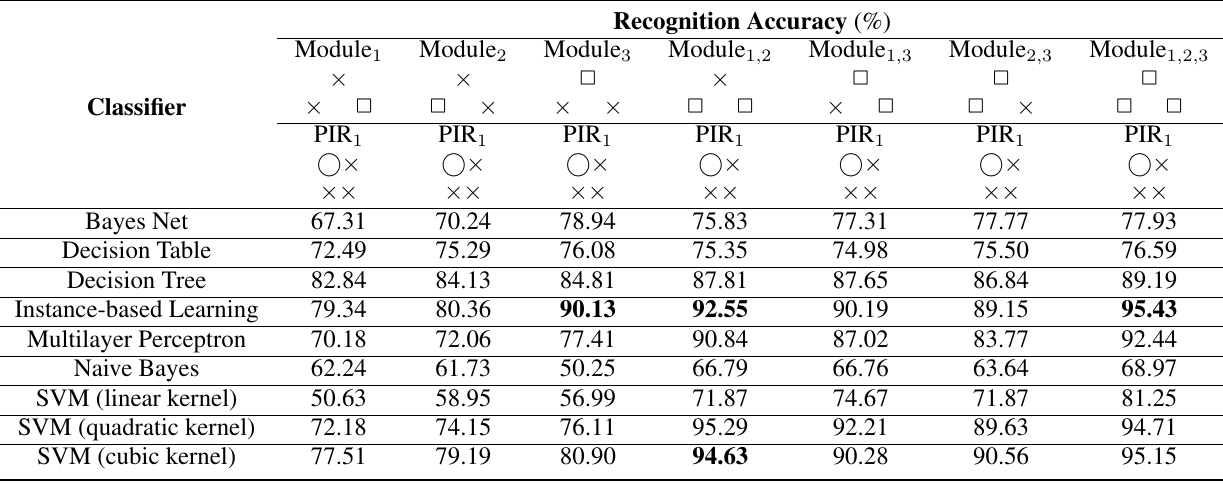
Table 6. Comparison of the recognition accuracy (%) of classifying walking speed levels based on the raw data set (PIR ) with respect to the number of 1